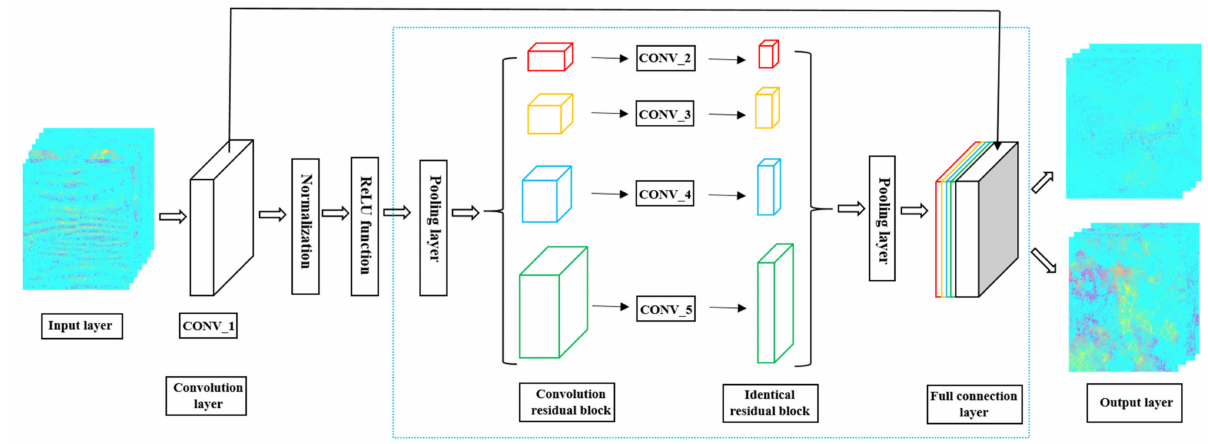
Figure 1. Structural design of the ResNet50 model.